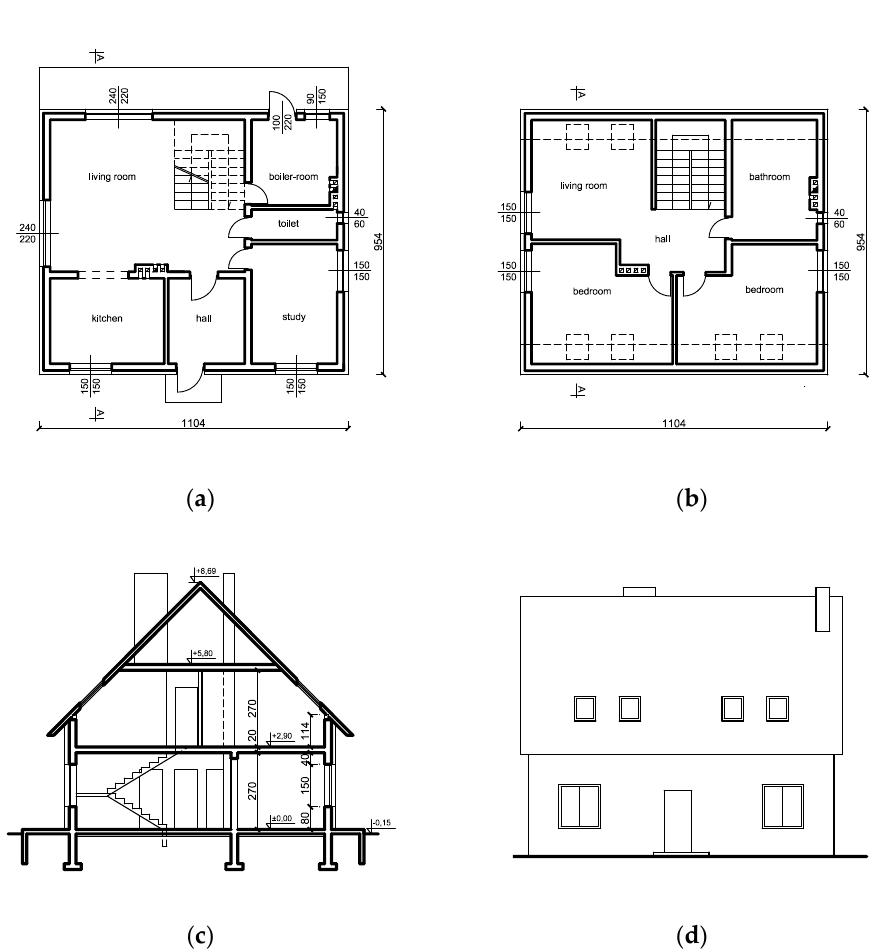
Figure 1. Scheme of the tested single-family house: ( a ) Ground floor plan; ( b ) Plan of heated attic; ( c ) Vertical section; ( d ) Front elevation (own elaboration).